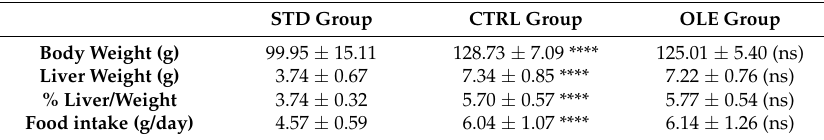
Table 3. Biometric parameters and food intake.